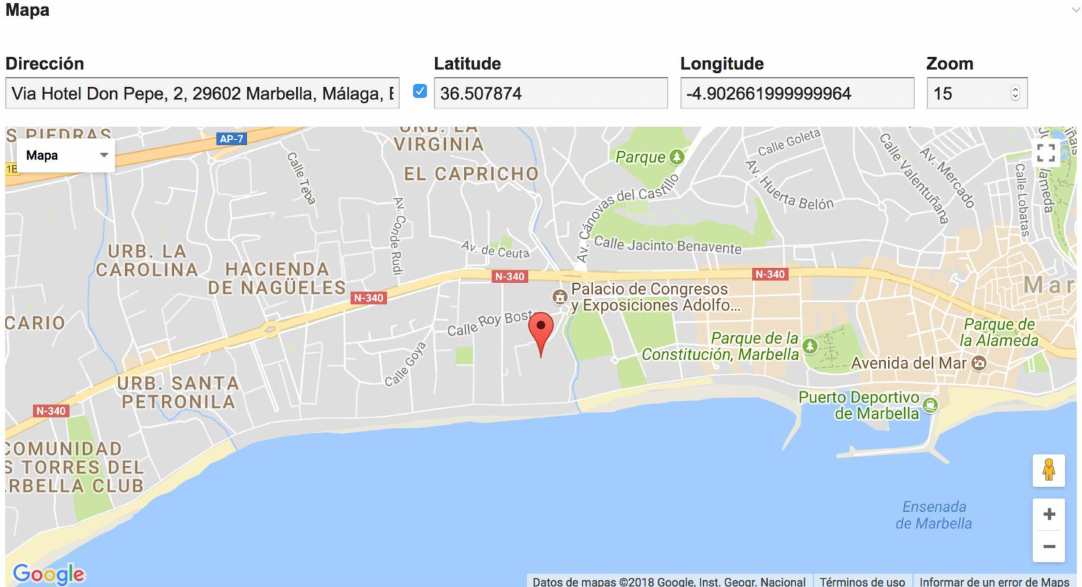
Figure 11. Locating an item in the back end. ProcessWire’s “Map Marker (Google Maps)” module enables researchers to enter latitude and longitude (or a street address) to quickly locate the item they are working on. Geocoding and reverse geocoding are supported through the Google Maps API. Screenshot by the N-340 research team, January